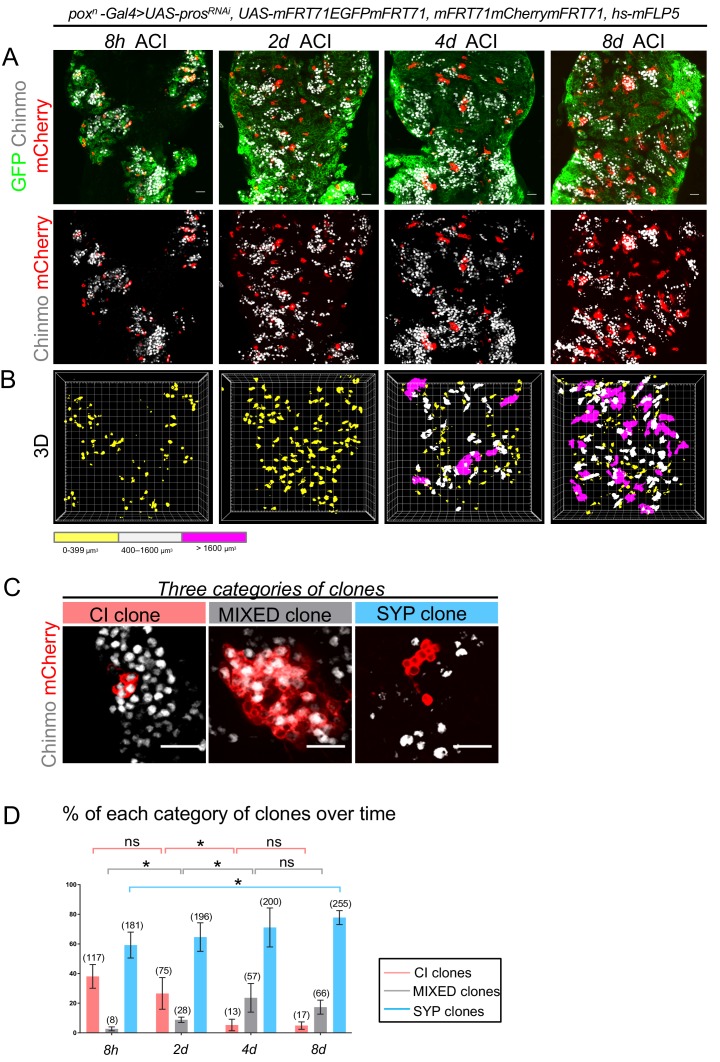
Clonal analysis in poxn > prosRNAi NB tumors.(A) Clones are labeled with mCherry and observed 8 hours (8h), 2 days (2d), 4 days (4d) and 8 days (8d) after clonal induction (ACI) in poxn > prosRNAi tumors. mCherry- tNBs are GFP+. Images represent one confocal section. (B) 3D projections of clones 8 hr, 2d, 4d and 8d ACI. The color-code labels clones according to their volume. (C) Three categories of clones can be identified in poxn > prosRNAi tumors: clones composed of Chinmo+Imp+ tNBs only (CI clones), clones composed of both Chinmo+Imp+ and Syp+E93+ tNBs (MIXED clones), and clones composed of Syp+E93+ tNBs only (SYP clones). Chinmo+Imp+ tNBs are identified by the presence of Chinmo. Syp+ tNBs are identified by the absence of Chinmo. (D) Proportion of CI (red), MIXED (gray) and SYP (blue) clones 8h, 2d, 4d and 8d ACI. Proportion of CI clones 8h ACI (n = 117 clones from 4 VNCs); 2d ACI (n = 75 clones from 4 VNCs); 4d ACI (n = 13 clones from 5 VNCs); 8d ACI (n = 17 clones from 5 VNCs). P between CI clones at 8h and 2d ACI -> PCI8h/2d = 0.2; PCI2d/4d = 0.016; PCI4d/8d = 0.88. Proportion of MIXED clones 8h ACI (n = 8 clones from 4 VNCs); 2d ACI (n = 28 clones from 4 VNCs); 4d ACI (n = 57 clones from 5 VNCs); 8d ACI (n = 66 clones from 5 VNCs). PMIXED8h/2d = 0.029; PMIXED2d/4d = 0.016; PMIXED4d/8d = 0.31. Proportion of SYP clones 8h ACI (n = 181 clones from 4 VNCs); 2d ACI (n = 196 clones from 4 VNCs); 4d ACI (n = 200 clones from 5 VNCs); 8d ACI (n = 255 clones from 5 VNCs). PSYP8h/8d = 0.016. Scale bars, 20 µm.